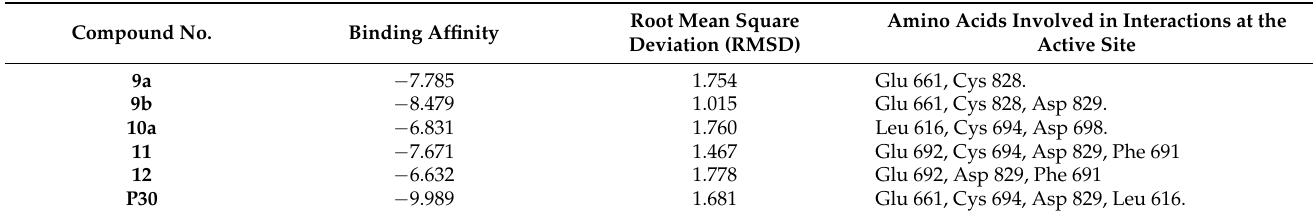
Table 3. Receptor binding affinity, RMSD values and residues involved in the interaction at the FLT3 active site.